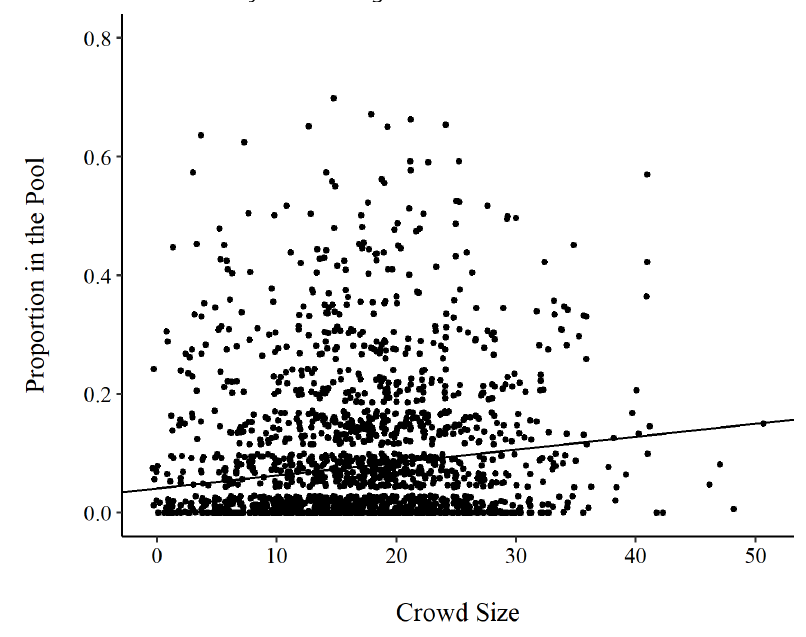
Effects of Crowd Size on Pool Use by Gentoo Penguins